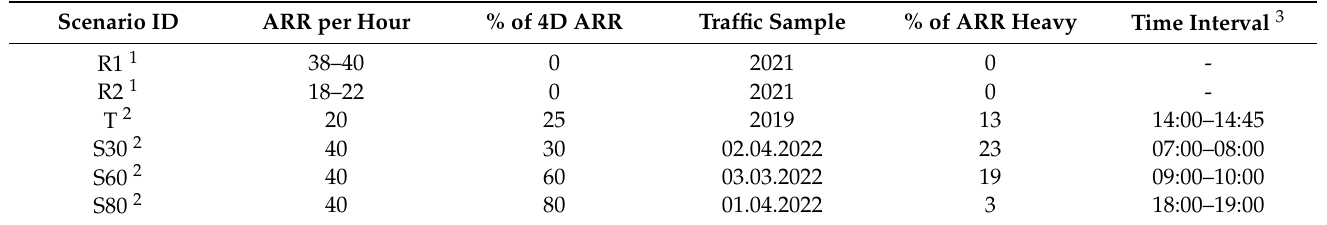
Table 1. Reference and simulation scenarios: composition and overview (ARR: